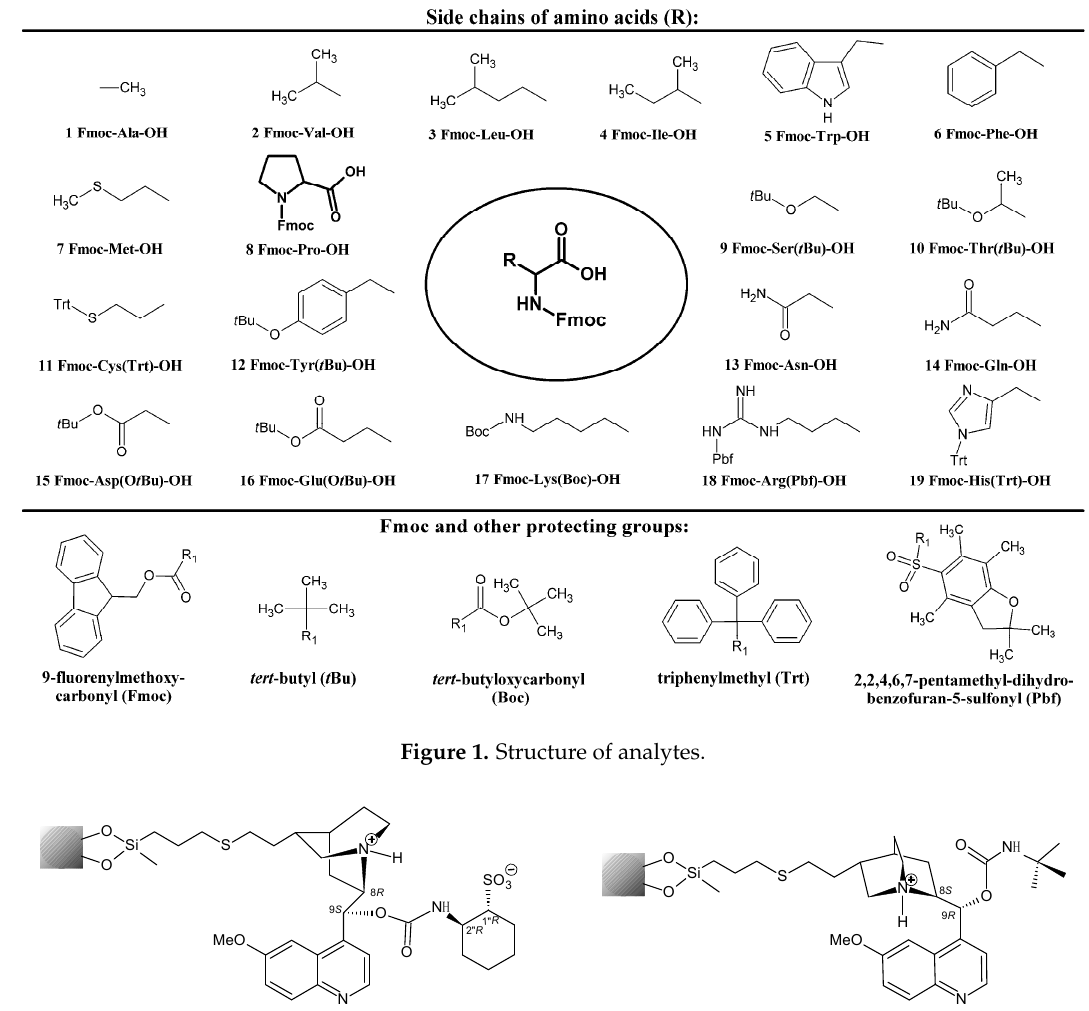
Figure 2. Structure of Chiralpak ZWIX(+)™ and QN-AX™ CSPs. Grey ball: represents the silica matrix.